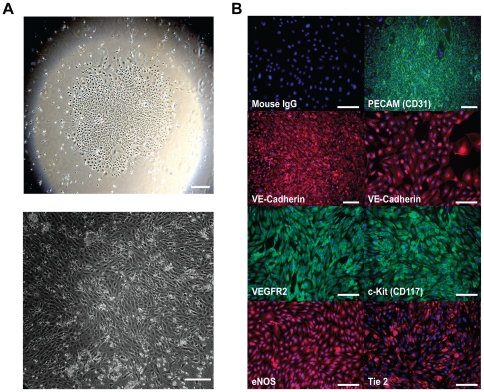
Characterization of porcine late outgrowth endothelial progenitor cells (LOEPCs).
Panel A: Phase contrast image of porcine LOEPC colony (upper image 2X magnification, lower image 10 x magnification, scale bar 500 microns). Panel B: Representative microscopic fields of LOEPCs are shown illustrating antigens characteristic of LOEPCs and endothelial cells; PECAM (CD31), VE-Cadherin (CD144), VEGFR2 (FLK1/KDR), c-Kit (CD117), endothelial specific nitric oxide synthase (eNOS), and Tie 2. Scale bars = 500 um. Results shown are representative of at least three independent experiments from separate animals.